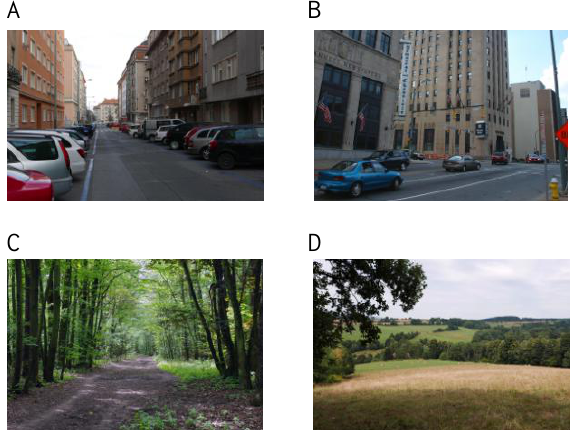
Figure 1. Examples of stimulus material. A, B - urban scenes, C, D - natural